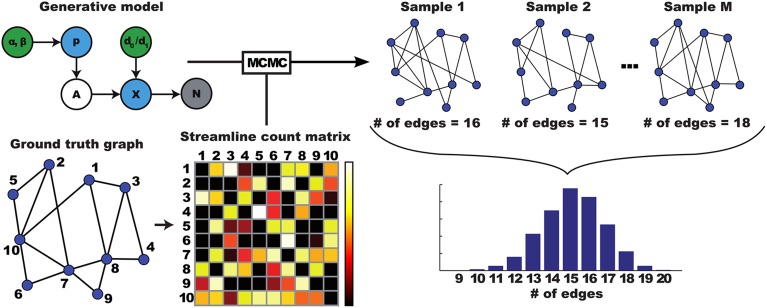
Illustration of how a distribution over networks is translated to a distribution over graph properties. A ground truth graph leads to streamlining data, which is used as input to an MCMC algorithm. This MCMC algorithm approximates inversion of the generative model given the data, by generating samples from the posterior distribution. Each of these sampled graphs can be analyzed using graph theoretical measures. Here, number of edges, resulting in a distribution over edge counts.